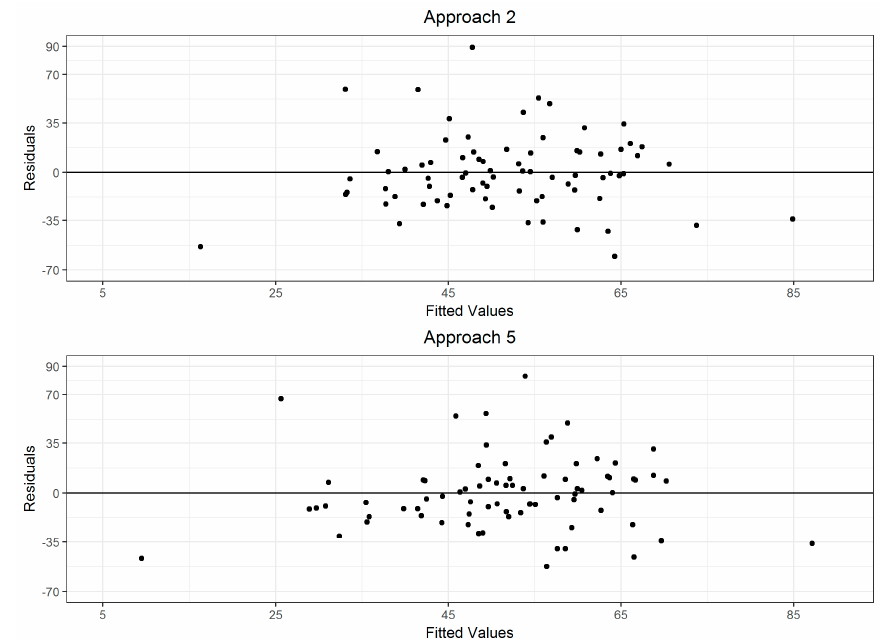
Figure 4. Plots of fitted values vs. residuals obtained in modeling change in volume (m 3 ha − 1 ) using change in lidar metrics using fixed (Approach 2) and mixed (Approach 5) effects models.